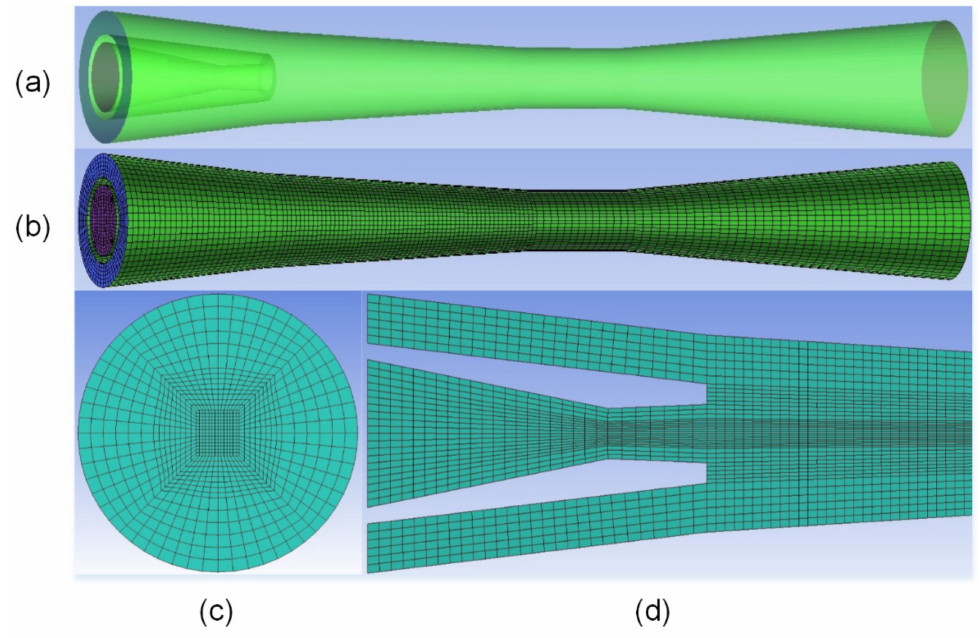
Figure 2. Simulation domain and mesh. ( a ) Schematic model of simulation domain; ( b ) Overall geometry showing external surface mesh; ( c ) Local mesh detail in radial section; ( d ) Local denser mesh in axial section of steam nozzle and mixing chamber.